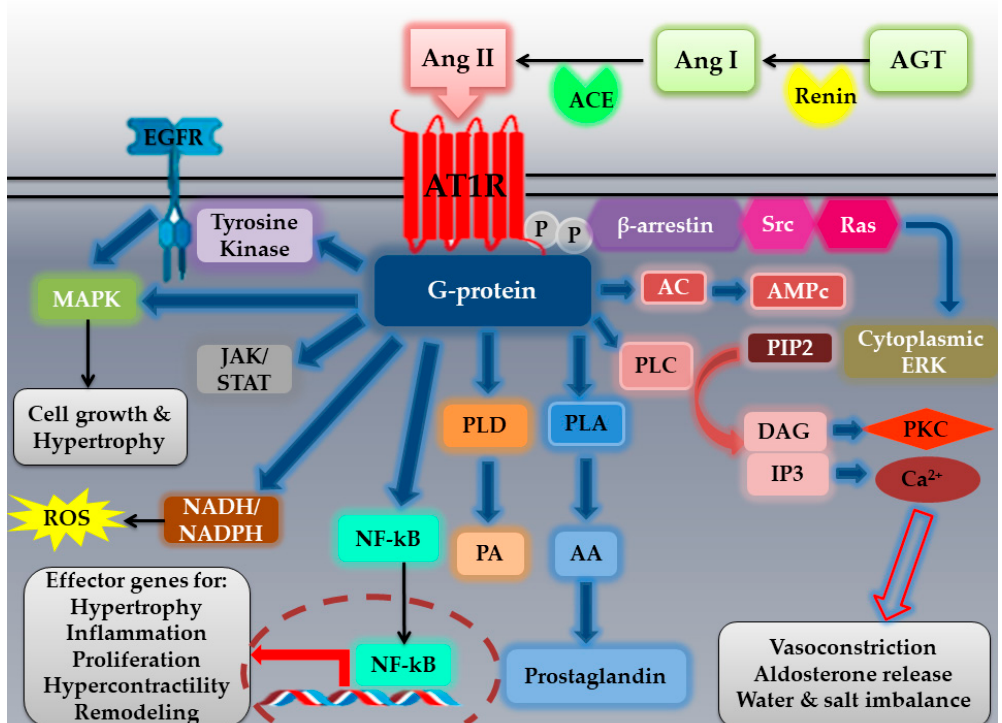
Figure 2. Angiotensin II type I receptor (AT1R) activation by angiotensin II (Ang II) and its sig- naling pathways. Ang II is produced from the conversion of AGT to Ang I by renin, and then, Ang I is cleaved by ACE into Ang II. Ang II is recognized by a G-protein-coupled receptor, AT1R. The agonist ligand (Ang II) binding to AT1R activates several signal transduction pathways, including noncanonical downstream effectors such as PLA, PLD, and PLC generating AA, PA, and IP3 and DAG, respectively. In turn, IP3 and DAG lead to Ca 2+ and PKC activation, respectively implicated in water and salt balance, as well as aldosterone release and vasoconstriction. Canonical GPCR signaling activates receptor tyrosine kinases such as EGFR, as well as activating the NADPH complex, resulting in the generation of ROS, a potent second messenger implicated in oxidative stress. In addition, AT1R stimulation results in activation of MAPK and NF- κ B transactivation. Together, this leads to pathophysiological responses such as hypertrophy, hypercontractility, proliferation, matrix production, inflammation, vascular remodeling, and hypertension. JAK/STAT activation by AT1R is involved in promoting cellular survival, migration, adhesion, and apoptosis. More- over, AT1R rapidly undergoes desensitization through phosphorylation, which leads to β -arrestin as a scaffold for signaling effectors such as Src, resulting in downstream activation of